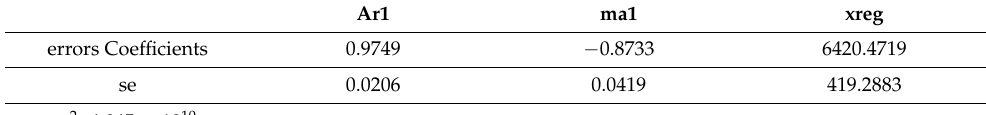
Table 4. Deterministic model (Regression with ARIMA